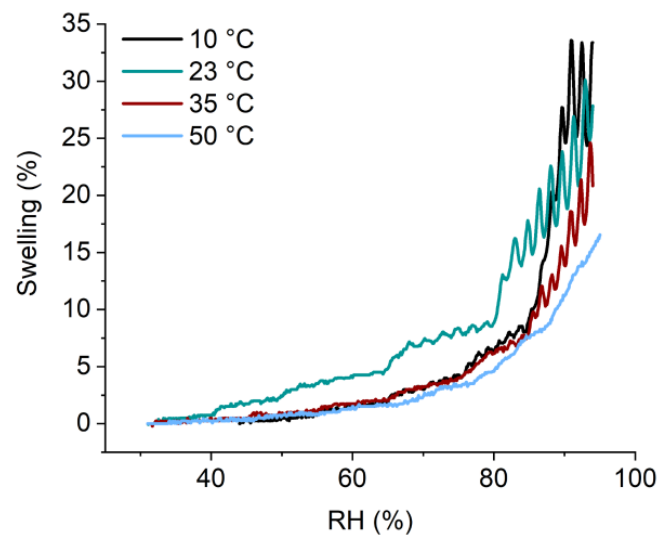
Figure 6. Swelling of the temperature responsive hydrogel at different temperatures and humidity levels, performed with setup I. The hydrogel was deposited on ZnO/Si.